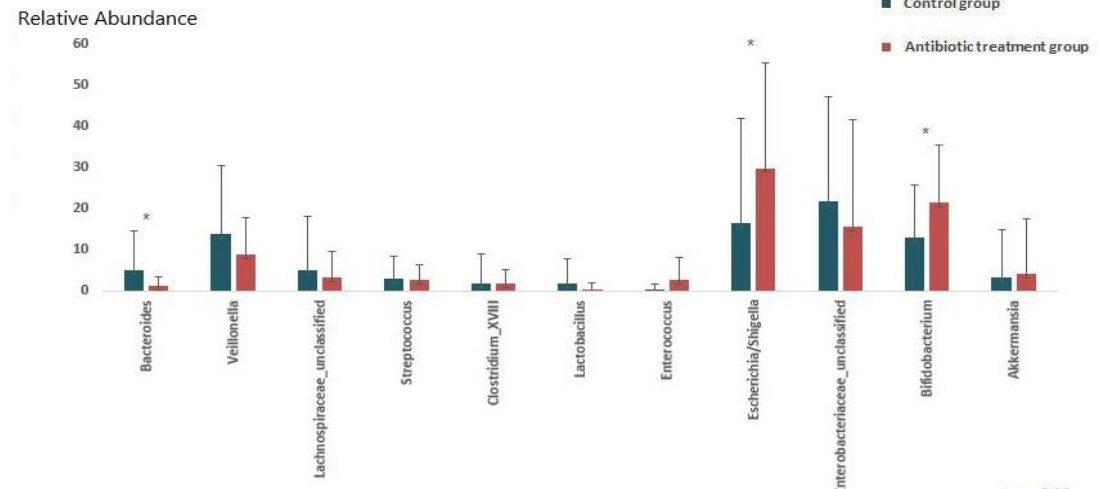
Figure 3. Comparison of gut microbiota between the control and antibiotic treatment groups at the genus level.